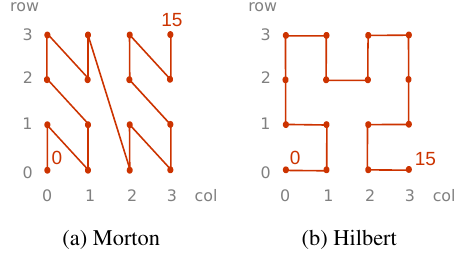
Figure 2. Space filling